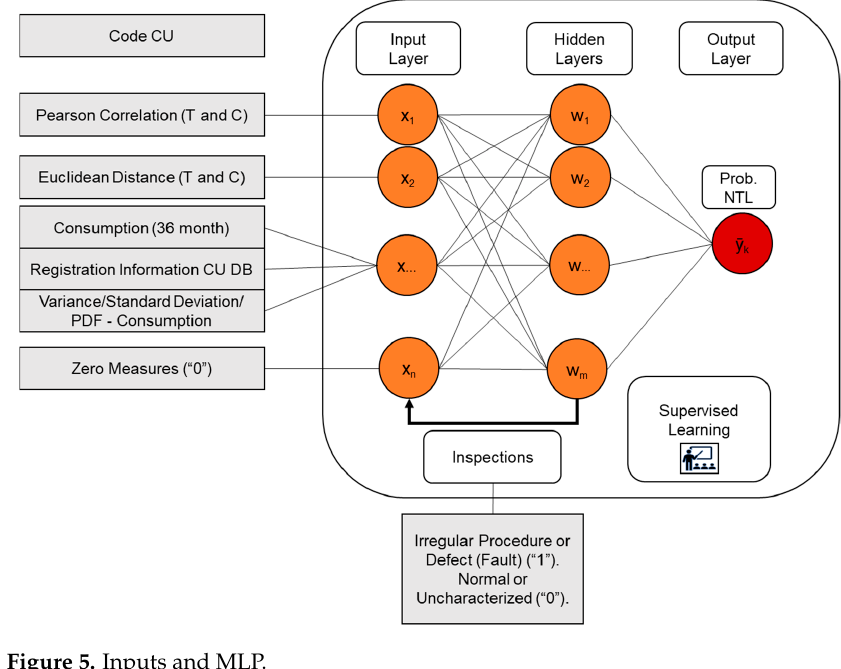
Energies 2022 , 15 , x FOR PEER REVIEW